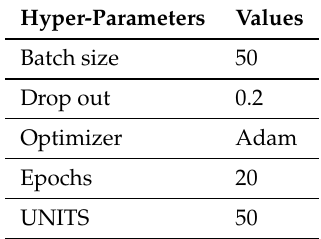
Table 4. Hyper-parameter values of